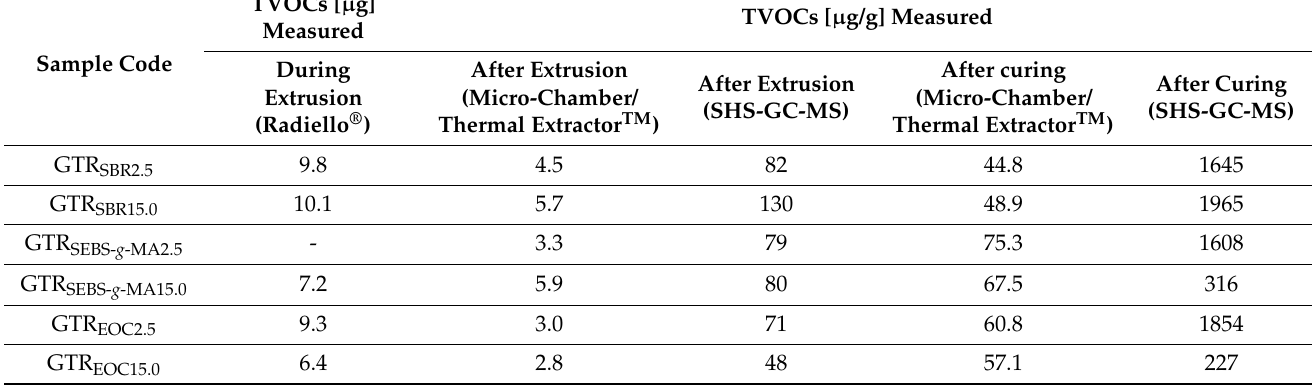
Table 8. TVOCs parameter measured by different techniques at a different time of preparing modified GTR